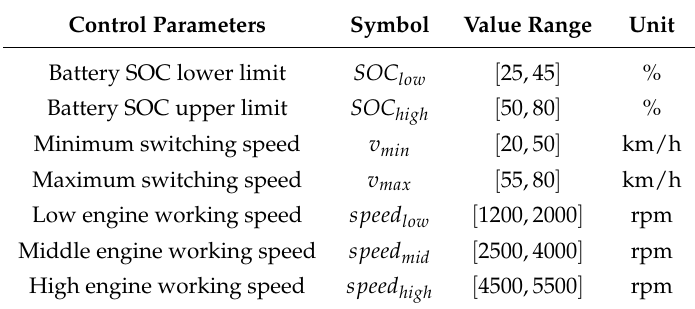
Table 7. Optimization parameters of E-REV energy management